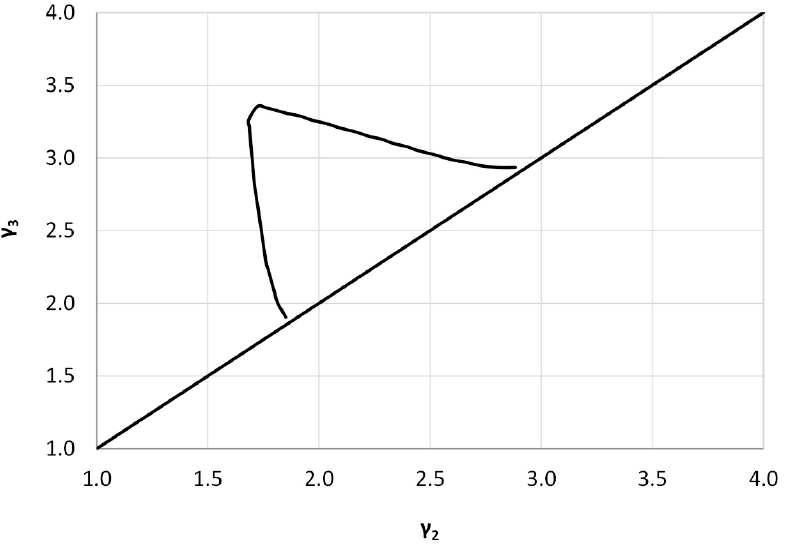
Figure 9. Separation region using a switching time of 4.5 min and a 20% safety factor for γ 1 and γ 4 .